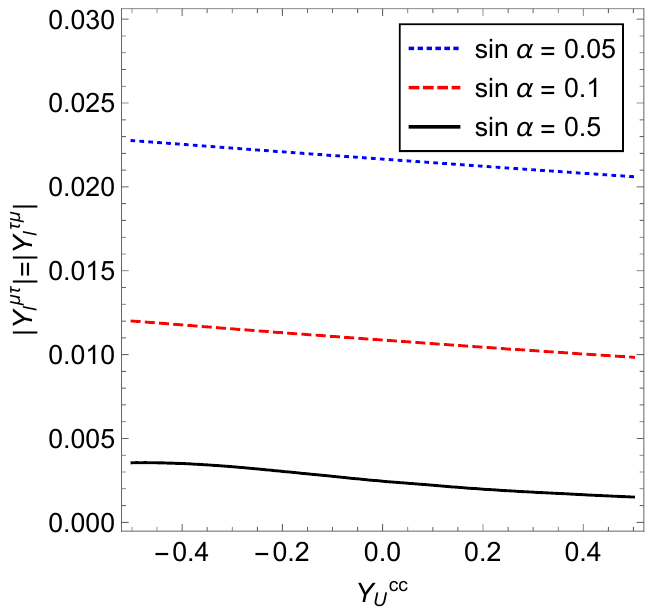
Figure 20. Estimated bounds on Y (cid:28)(cid:22) The region above each curve is excluded.